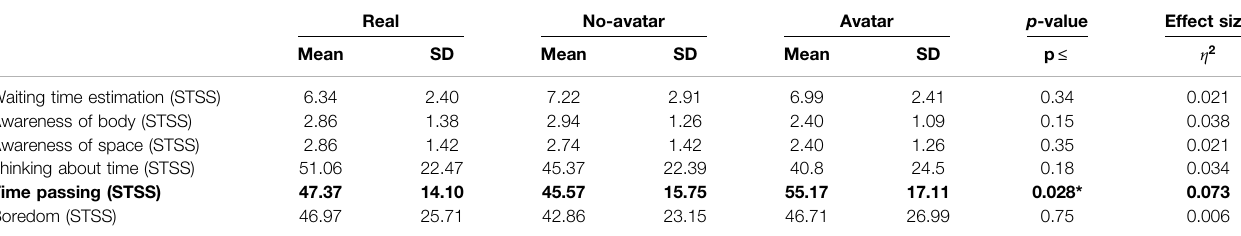
TABLE 2 | Main results — STSS.